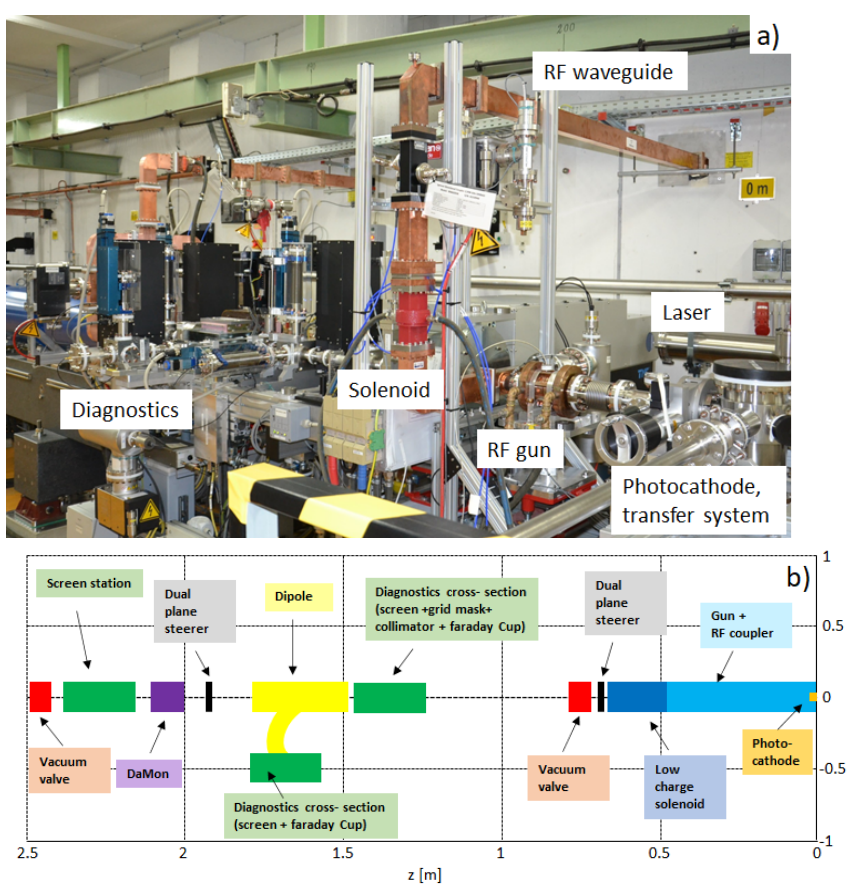
Figure 2. Layout of the ARES photoinjector. ( a ) Setup of the ARES photoinjector in the SINBAD tunnel, including the RF gun with RF waveguides, magnets and a diagnostic line. ( b ) Schematic overview of the ARES gun section with the gun, magnets and diagnostic